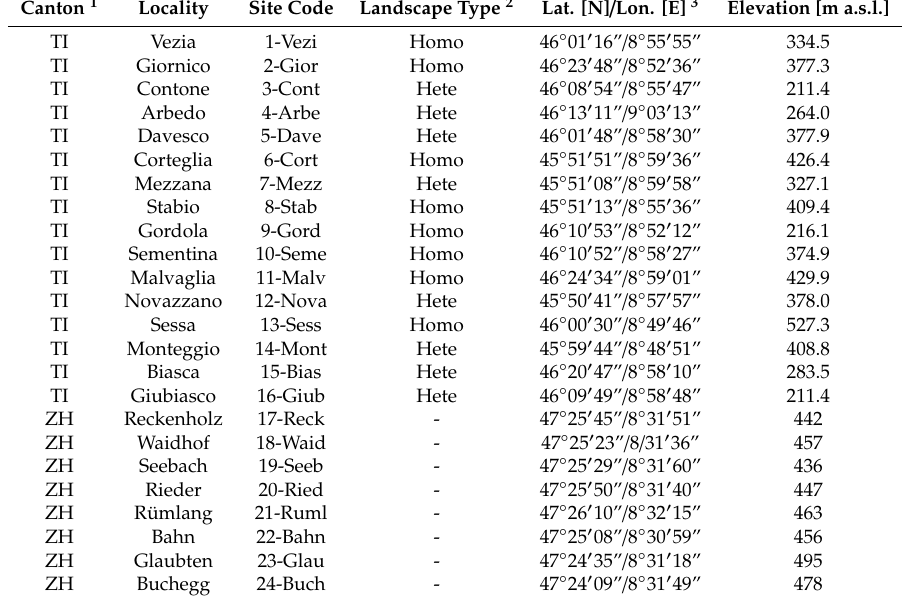
Table 1. List of the 24 localities investigated in 2017 in Switzerland. Locality, coordinates and altitude are reported for both Ticino and Zurich region, and landscape type for